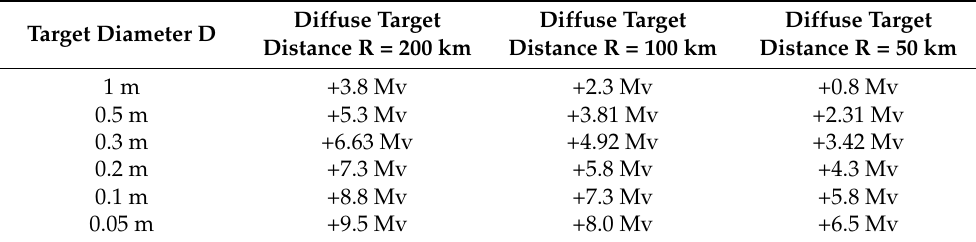
Table 1. Analysis of brightness characteristics of typical spherical targets. Diffuse Target Diffuse Target Diffuse Target Target Diameter D Distance R = 200 km Distance R = 100 km Distance R = 50